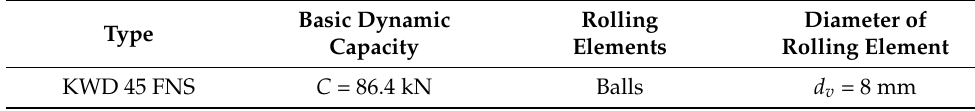
Table 1. Parameters of Bosch Rexroth linear rolling